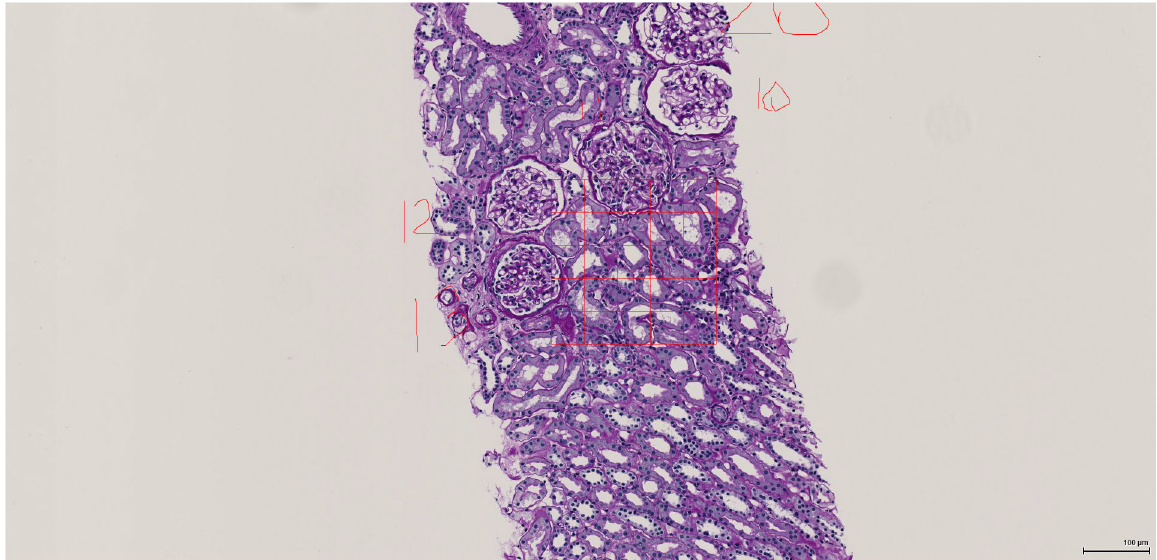
Fig 1. Illustration of the point counting method on a section of cortex (PAS stain). Illustration of the point counting principle for assessing cortical compartments using SlidePath software. The hand-written numbers (10, 11, 12, 13 and part of 20) were added by the slide annotator, to keep track of individual glomeruli. Cross points of the red grid box were used other than the upper and right-side lines (equivalently, using the bottom-left corner point of each grid sub-box). Starting at the top-left, the first point ‘ hits ’ an intact glomerulus (#12). Moving right, the second point hits an intact tubule. The third hits an intact glomerulus (#11). Twenty-five points per grid are evaluated.